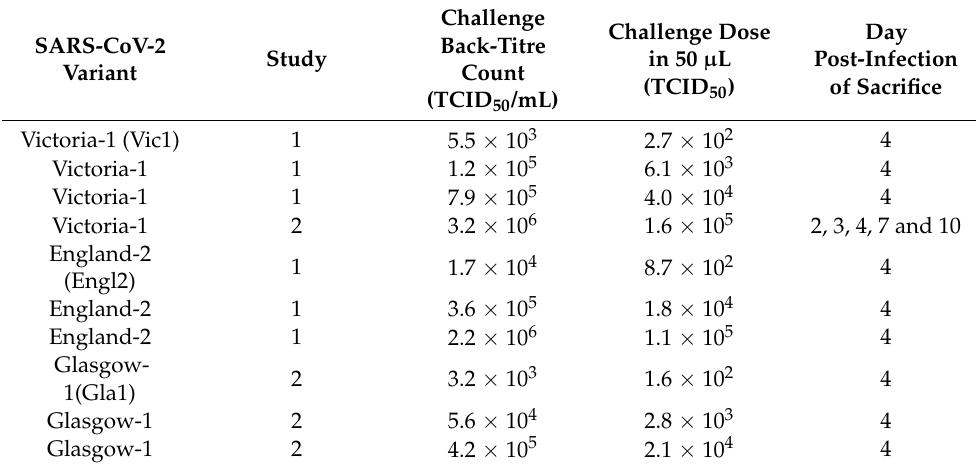
Table 1. Summary of isolates, doses and time-points collected from SARS-CoV-2 infected mice.